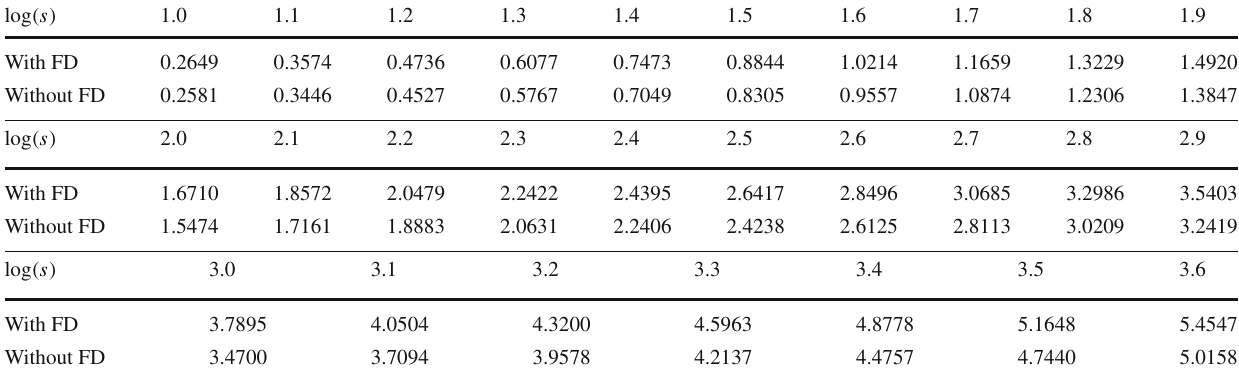
Table 8 Total π − yield as a function of log ( s ) with and without feed-down contribution log ( s